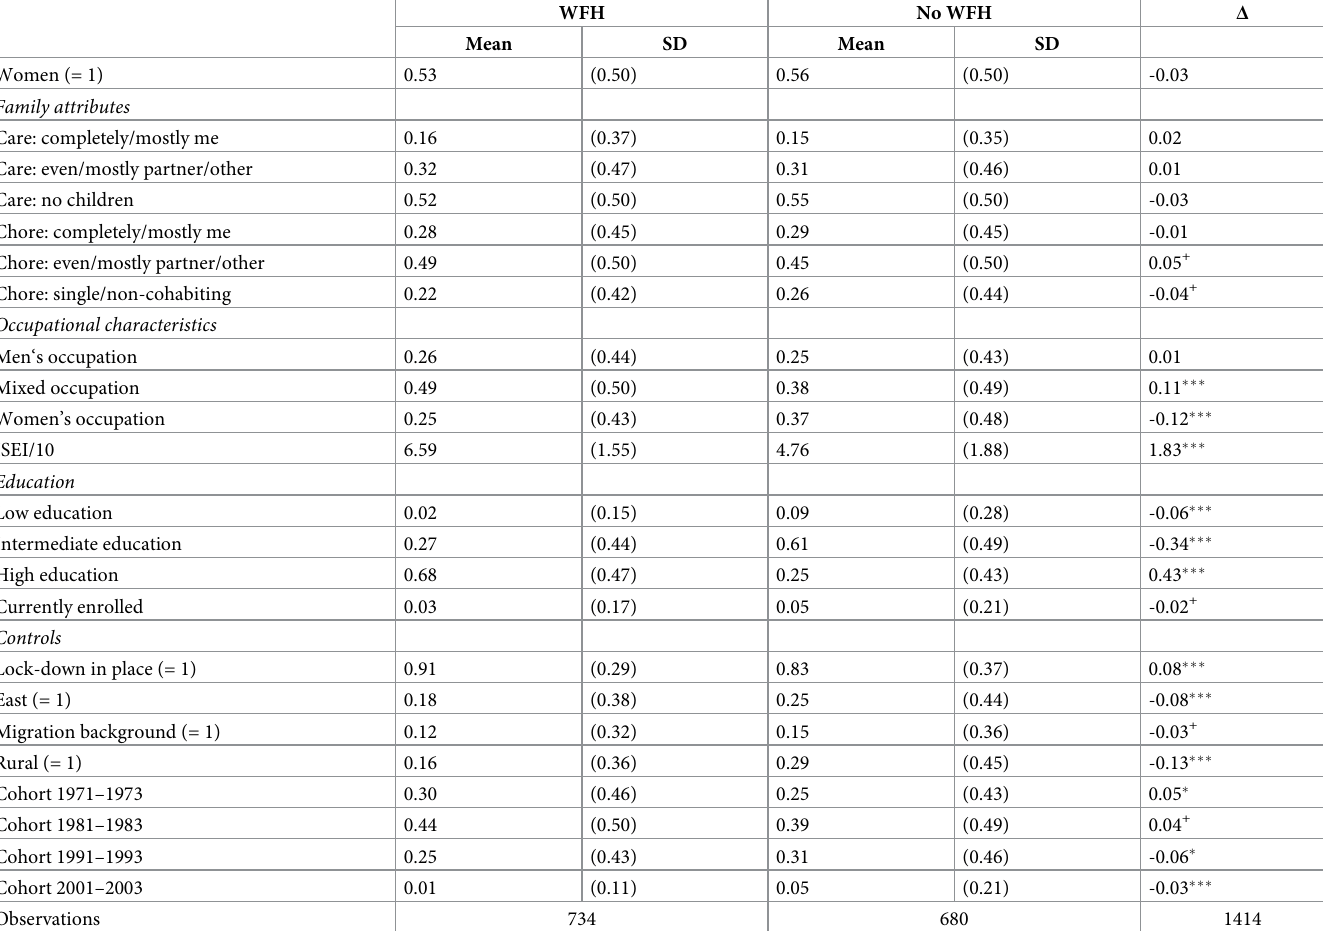
Table 1. Description of the sample by working from home (WFH) and the differences between the two